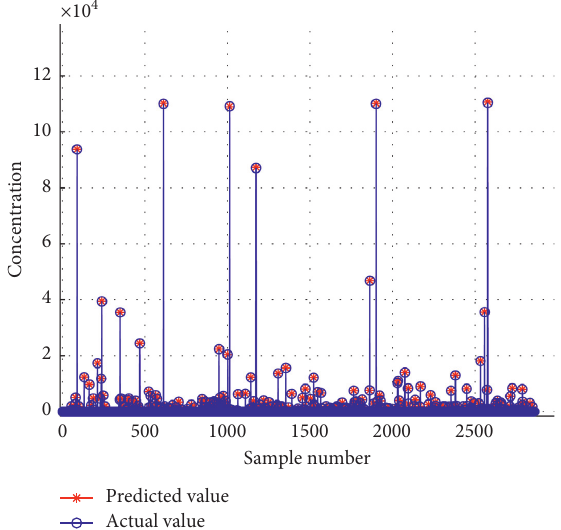
Figure 7: The prediction effect diagram of overall modeling test set